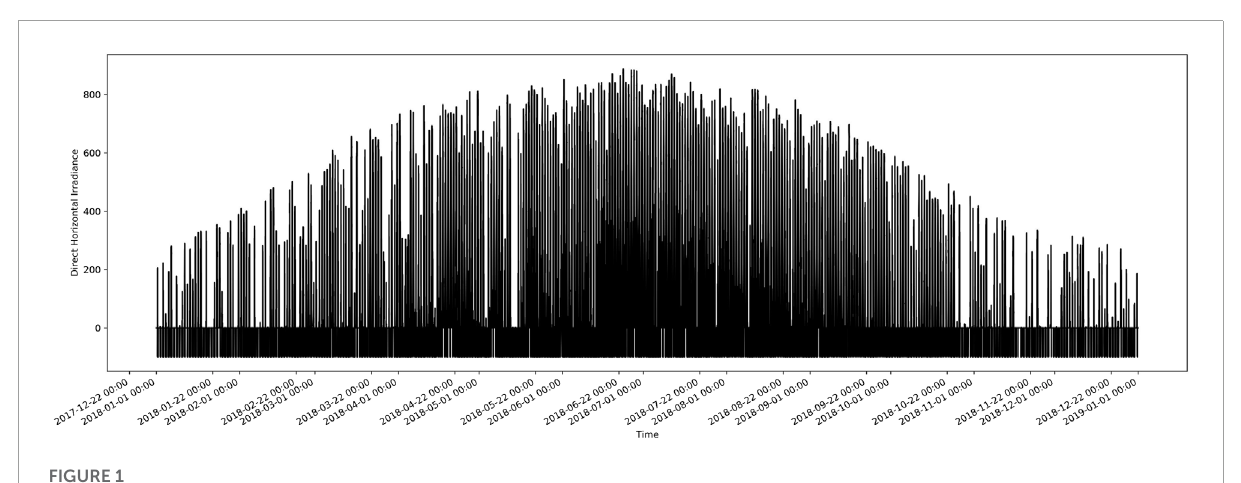
FIGURE 1 Direct horizontal irradiance source data from Lyon,